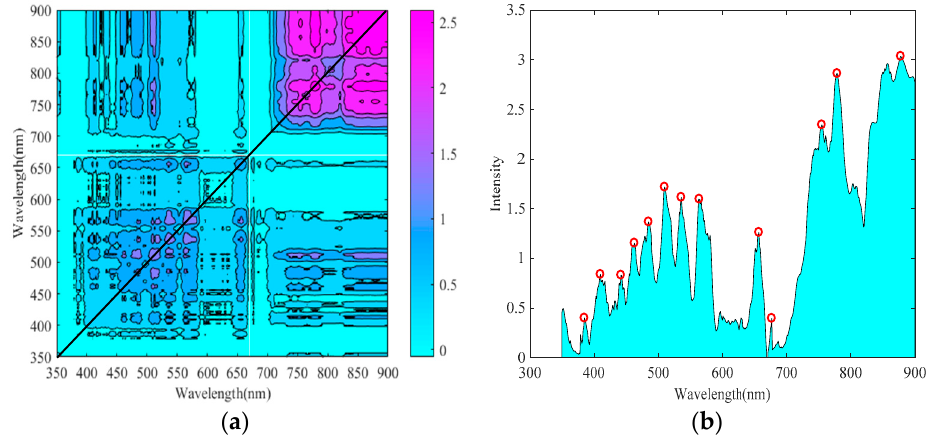
Figure 6. 2D correlation spectra of the winter wheat canopy for the heading period: ( a ) Synchronous 2D spectra contour map; ( b ) diagonal of synchronous contour map.